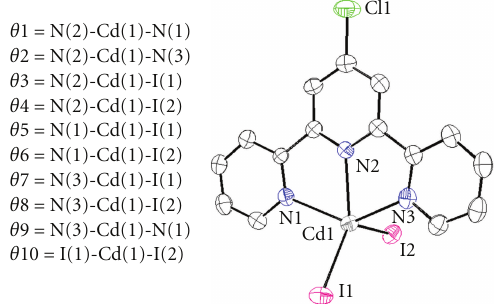
Table 2: Selected bond lengths/˚A and angles/ ◦